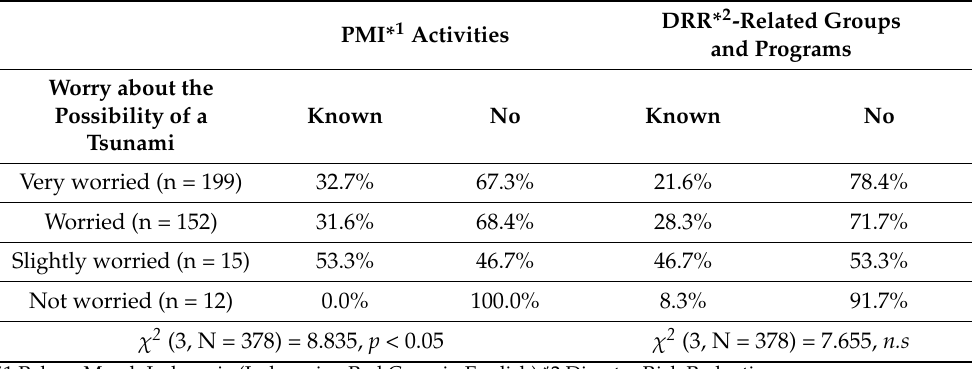
Table 15. Preparedness (knowledge) and worry about the possibility of a tsunami (N =